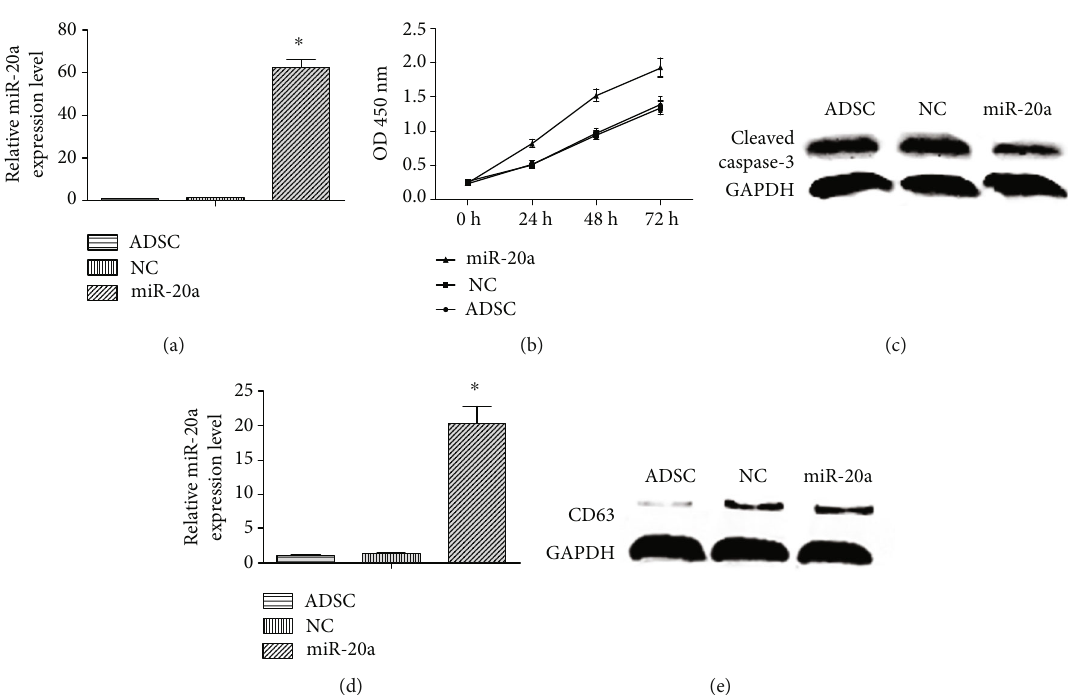
Figure 1: miR-20a overexpression promotes cell proliferation and inhibits apoptosis of ADSCs, and miR-20a-ADSC-derived exosomes exhibit upregulated miR-20a expression: (a) miR-20a expression levels; (b) cell proliferation; (c) cleaved caspase-3 expression levels in di ff erent groups; (d) miR-20a expression in exosomes; (e) CD63 expression in exosomes of the NC and miR-20a groups (the ADSC group consists of ADSCs only). The data are expressed as the mean ± SD . ∗ P < 0 : 05 vs. ADSC group. ADSC: adipose-derived stem cell group; miR-20a: miR-20a-ADSC group; NC: negative control